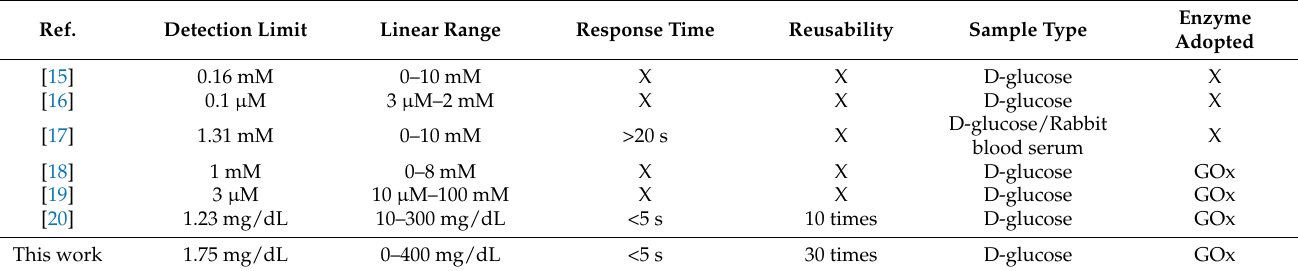
Table 2. Performance comparison of nanowire glucose